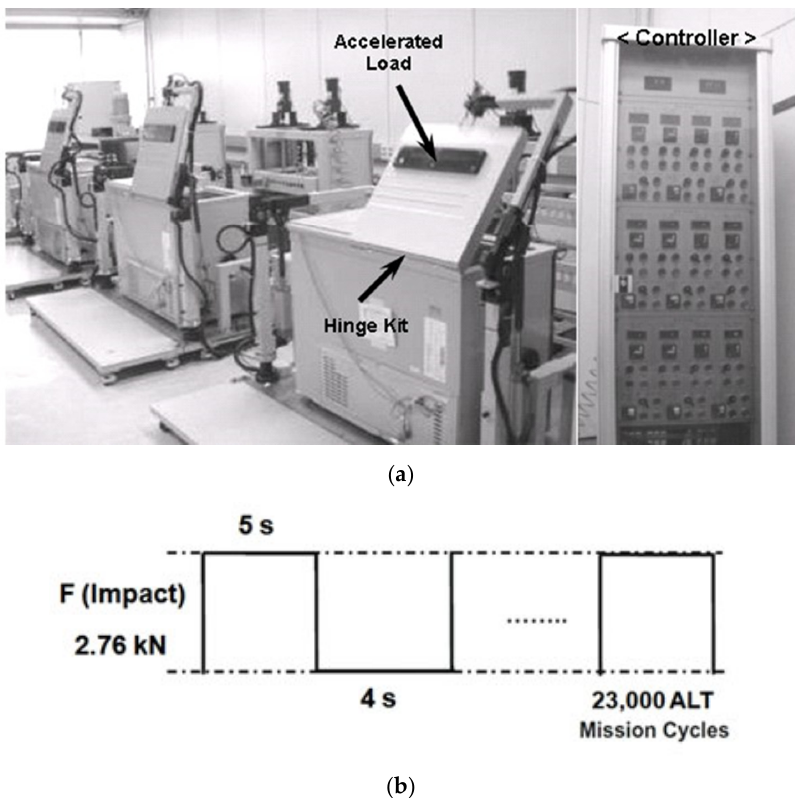
Figure 8. ALT ( a ) equipment; ( b ) duty cycles of repeated impact load F.